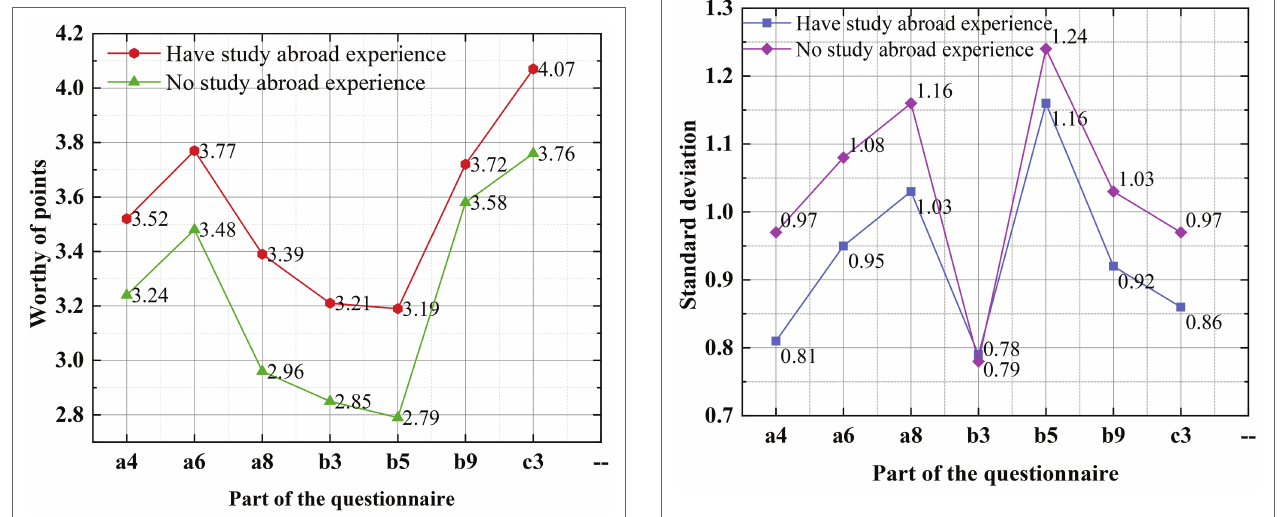
FIGURE 5 | Mean standard deviation of the scores of the subjects.